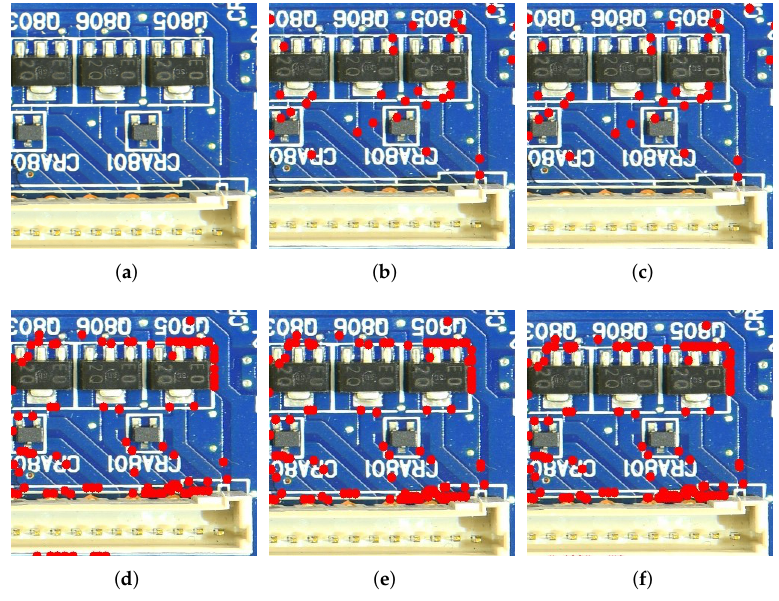
Figure 8. Corner Subpixel feature images with different label mask k-size. ( a ) Original image patch, and ( b – f ) respective experimental results from 25 to 5 image mask size. These six images are different